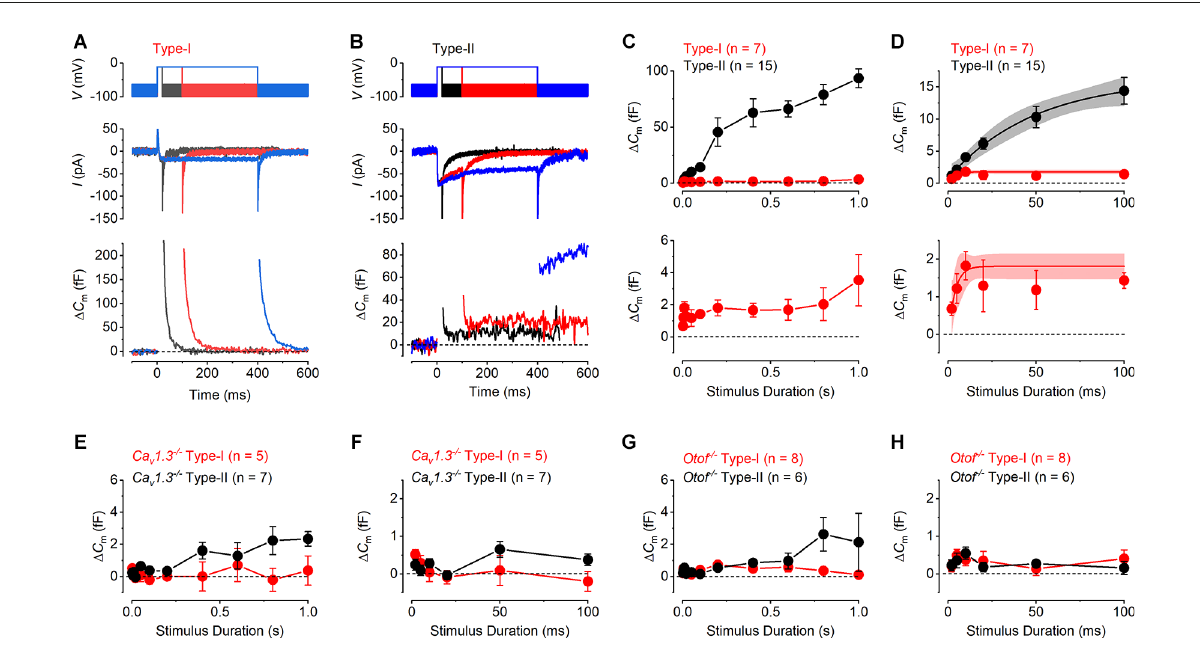
FIGURE5 Vesicle pool dynamics in mature mouse utricular hair cells. (A,B) Calcium current ( I Ca : middle panels) and corresponding ∆ C m (bottom panels) responses recorded from a type-I (A) and a type-II (B) hair cell, elicited by applying voltage steps to − 11 mV of 20, 100, and 400 ms in duration (upper panels). (C) Average sustained ∆ C m responses from type-I ( n = 6) and type-II ( n = 15) hair cells to the different stimulus durations (upper panel). Type-II hair cells displayed a triphasic profile of vesicle pool release dynamics, representing the release of the RRP, followed by the release of a larger SRP and a final cytoplasmic pool component. By contrast, type-I hair cells showed a very small sustained ∆ C m component even at the longest stimulus durations (1 s). The lower panel shows the same values plotted in the upper panel for the type-I hair cell but on an expanded y-axis. (D) RRP component in both hair cell types (upper panel) could be fitted with a single exponential, which is also shown on an expanded y-axis for type-I hair cells in the lower panel. (E) Average sustained ∆ C m responses from type-I ( n = 5) and type-II ( n = 7) hair cells from Ca V 1.3 − / − mice to different stimulus durations up to 1 s. (F) Average ∆ C m responses as in (E) but showing the initial 100 ms that would represent the RRP. (G) Average sustained ∆ C m responses from type-I ( n = 8) and type-II ( n = 6) hair cells from Otof − / − mice to different stimulus durations up to 1 s. (H) Average ∆ C m responses as in (G) but showing the initial 100